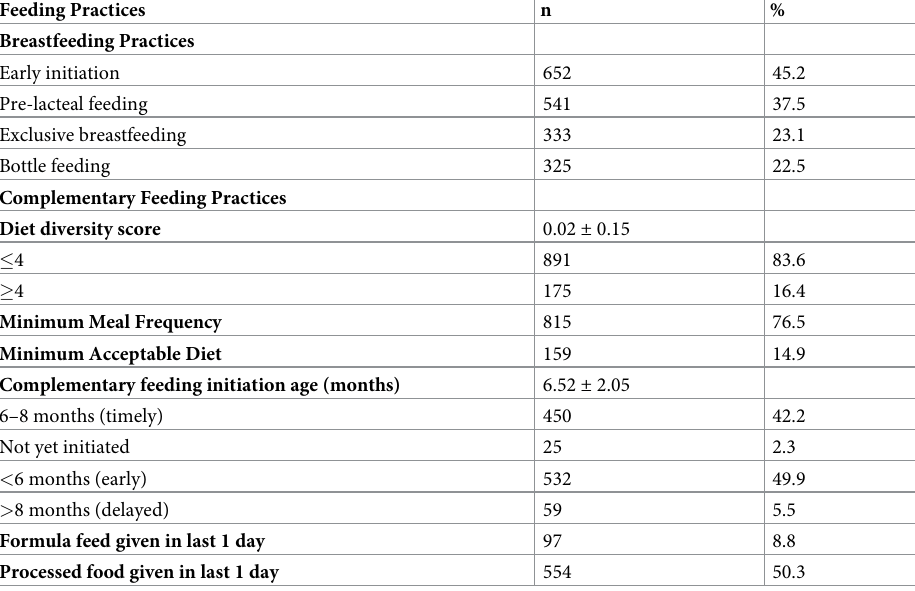
Table 3. Distribution of Infant and child-feeding